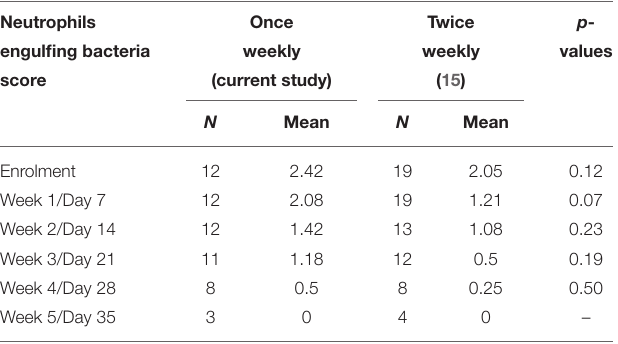
TABLE 6 | Summary of NES values between once and twice weekly FBM application.